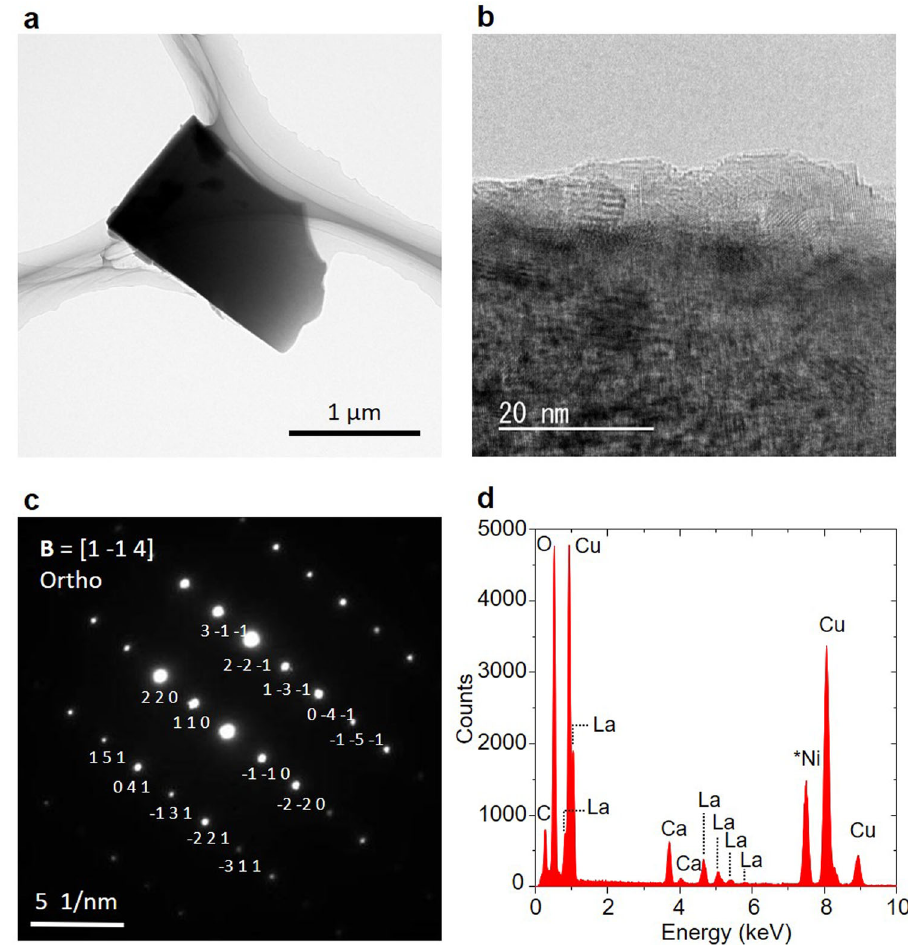
Fig. 6 TEM. The sample was the fi lter residues of polycrystalline LCCO subjected to immersion to NaOH aqueous solution with 5 mol/L concentration and 6 h stirring time. a Bright- fi eld image of the thin sheet. b Lattice image in the edge. c Electron diffraction pattern. d EDX spectrum. The peak due to Ni is derived from the Ni mesh holder.